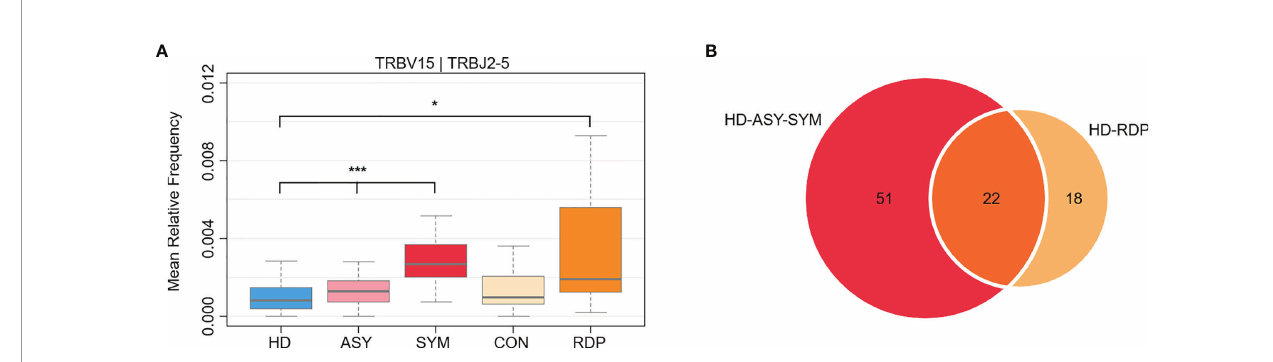
FIGURE 5 | Differential V – J gene usage between different groups. (A) An exemplary V – J combination showing a monotonic increase through HD, ASY, and SYM courses, as well as a signi fi cant elevation in RDP group. (B) Among the monotonic V – J combinations, many were also differentially expressed in RDP cases. Statistical signi fi cance of the difference between groups is denoted as * for P < 0.05, *** for P